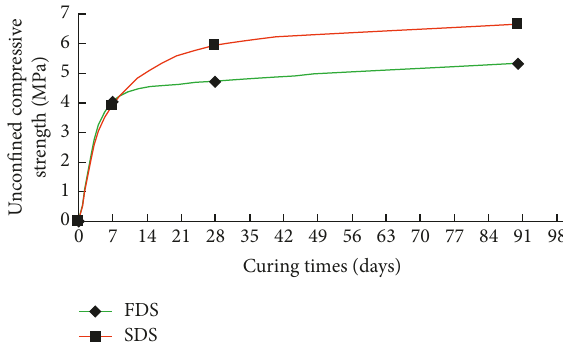
Figure 14: UCS of FDS and SDS growing with curing time.